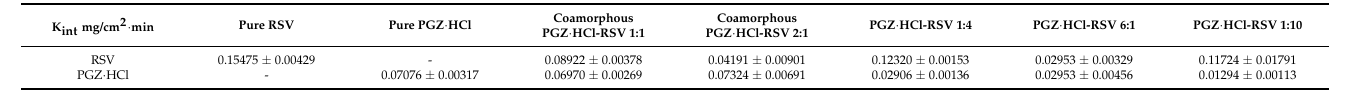
Figure 11. Dissolution profiles evaluating the release of RSV. Pure RSV, coamorphous forms of PGZ · HCl -RSV (2:1 and 1:1), and solid forms of PGZ · HCl-RSV (1:4, 6:1, and 1:10). Table 8. K int values for the synchronized release of pure RSV and PGZ · HCl. Likewise, coamorphous forms of PGZ · HCl -RSV (2:1 and 1:1) and solid forms of PGZ · HCl-RSV (1:4, 6:1, and